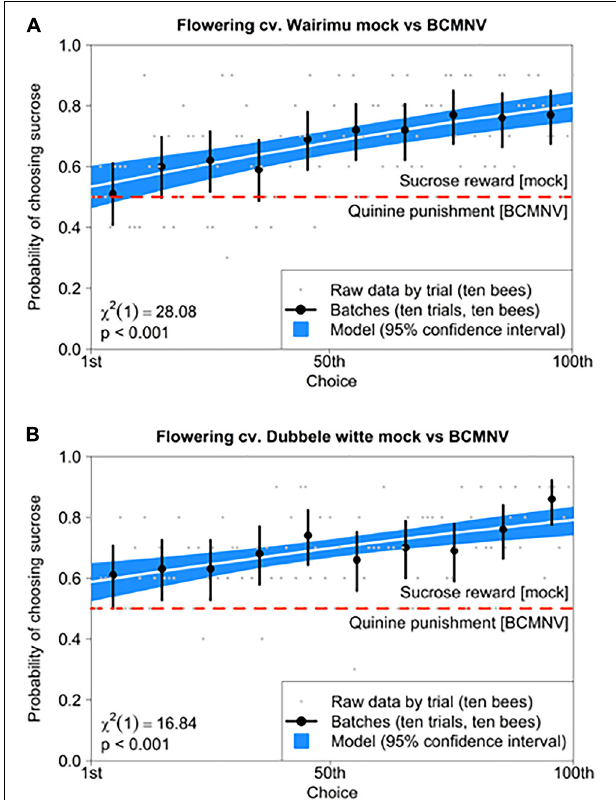
FIGURE 4 | Bumblebees can distinguish between VOC blends emitted by flowering non-infected and BCMNV-infected bean plants despite having no innate preference for either. Using differential conditioning with a sucrose reward and quinine punishment bumblebees learned to distinguish between VOC blends emitted by BCMNV-infected and mock-inoculated flowering common bean. The learning curve indicates the overall ability to distinguish between plant-emitted volatiles analyzed after 100 choices per bee using 10 bees. In flowering cv. Wairimu (A) , bumblebees initially chose the sucrose reward at a mean accuracy of 50% in their first 10 choices increasing to about 85% by choices 90 to 100 meaning bumblebees learnt to identify sucrose rewards based on the association with volatiles from flowering mock-inoculated plants. Similar results were obtained with flowering cv. Dubbele witte (B) , where bumblebees’ first 10 choices had a mean accuracy of 60% for sucrose increasing to a mean of c. 75% by choices 90 to 100. Data are shown pooled over all bees ( n = 10) into successive groups of 10 choices, with error bars showing 95% binomial confidence intervals for the proportion of correct choices. The white curve shows the fitted binomial generalized linear mixed model, with blue borders showing 95% confidence intervals on the fitted response. The χ 2 statistic and significance level for the likelihood ratio test assessing whether bees can learn are given at the bottom left of each